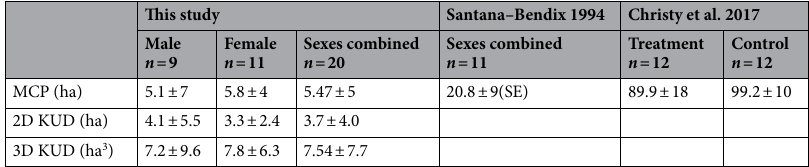
Table 2. Average (± SD) two-dimensional (minimum convex polygon (MCP) and 2D Kernel Utilization Distribution (KUD) and three-dimensional (3D KUD) activity areas for brown treesnakes ( Boiga irregularis ) in the Habitat Management Unit (HMU) during high prey availability. Activity areas from other studies are included for comparison. For the Christy et al. 2017 reference, Treatment = prey suppression plots created by applying rodenticide prior to monitoring, Control = plots not treated with